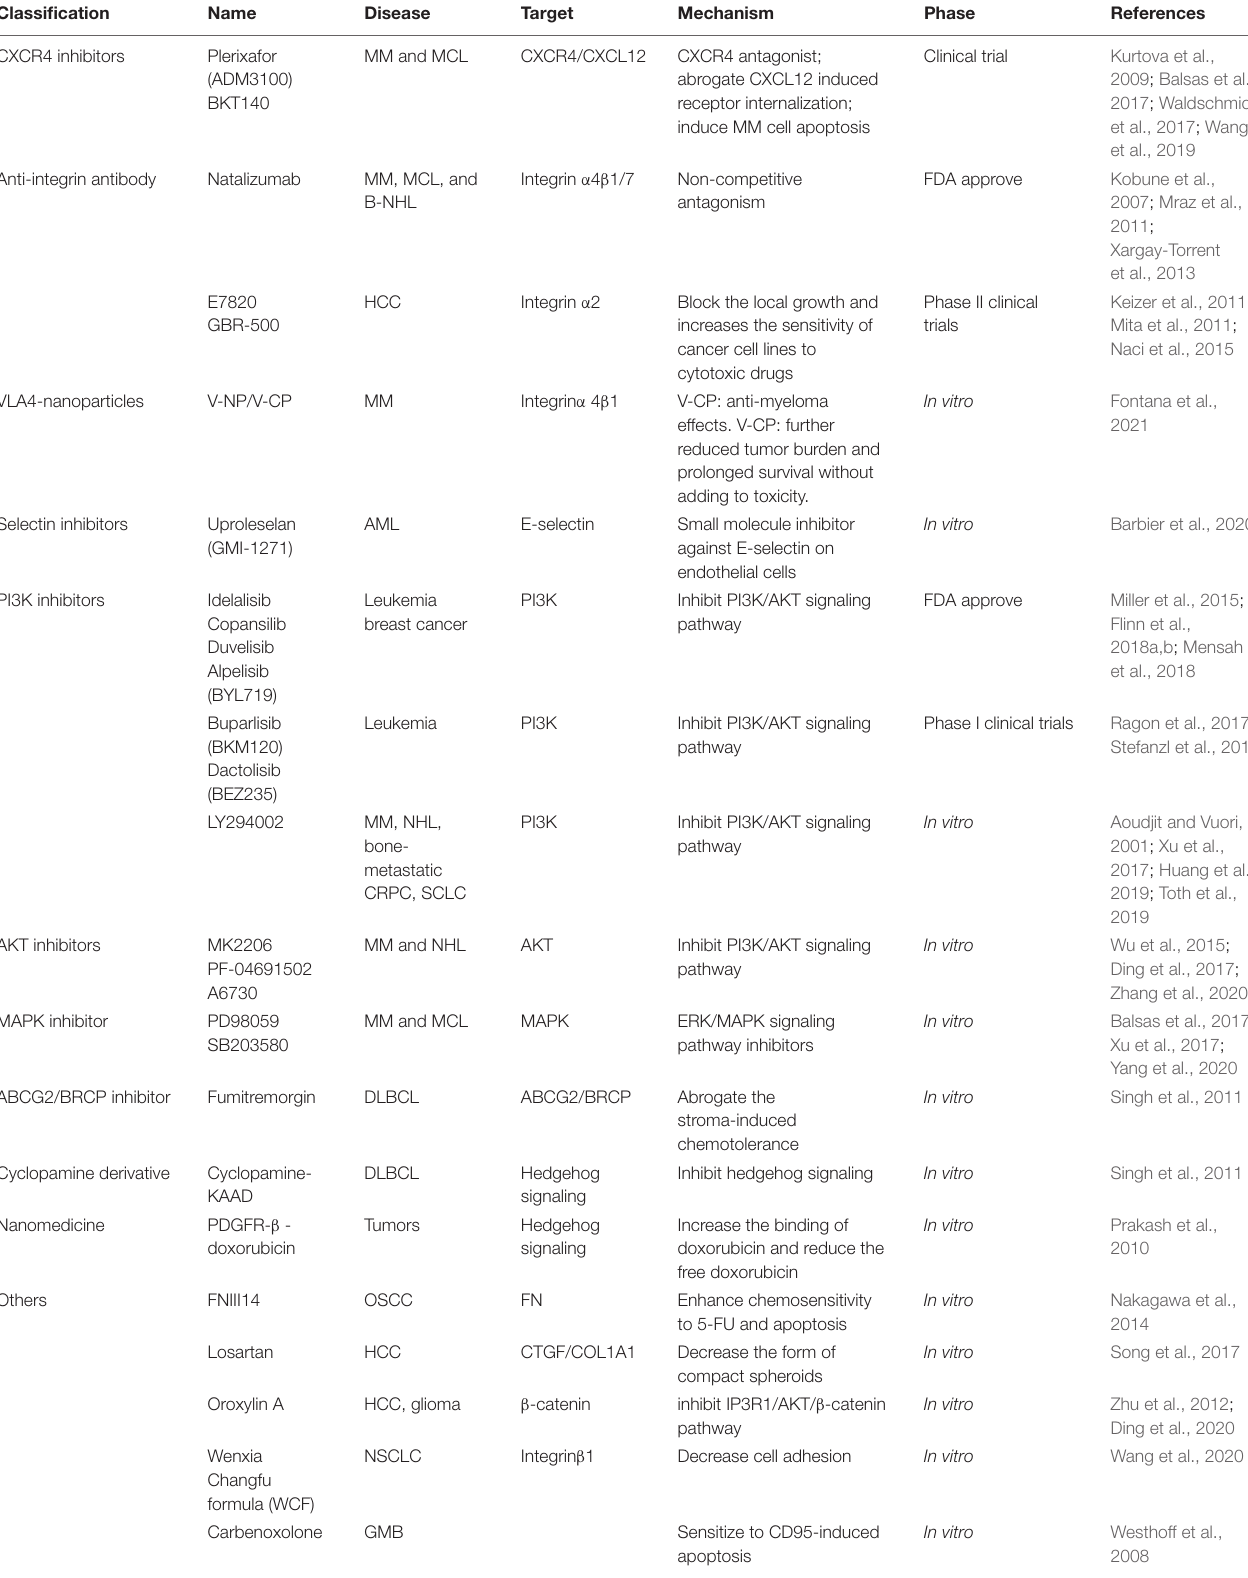
TABLE 4 | Overview of the targeting